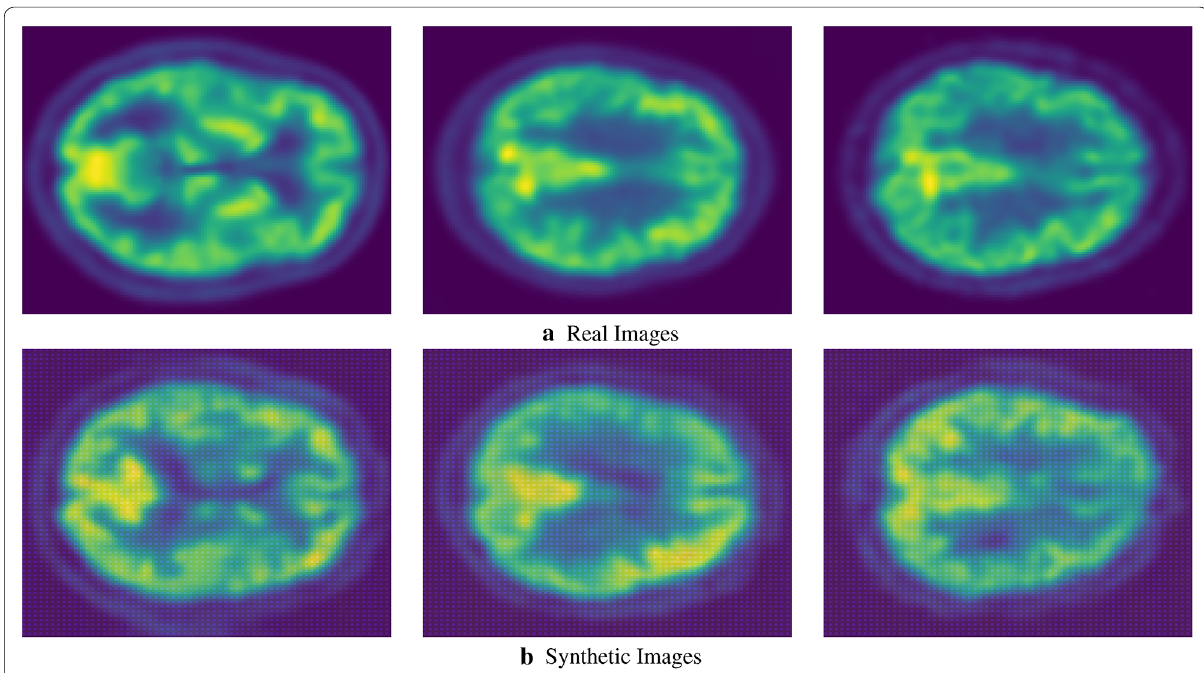
Fig. 6 Real and synthetic brain PET images of normal patient: a real b synthetic